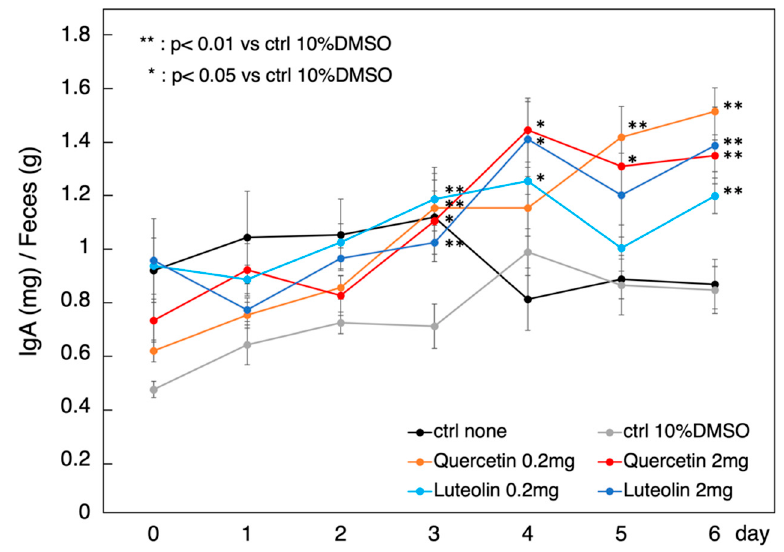
Figure 4. Effect of oral administration of Raldh2 -activating polyphenols on IgA production in the intestines of BALB/c mice. Quercetin and luteolin were administered orally to BALB/c mice ( n = 6), and total IgA was measured via enzyme-linked immunosorbent assays using mouse fecal samples. IgA expression is expressed as the mean ± standard error of mean mg/g fecal weight using a two- sided Student’s t -test. Significant differences were tested in comparison to results of the controls. Significance was defined as * p < 0.05, ** p < 0.01. Raldh2 : retinaldehyde